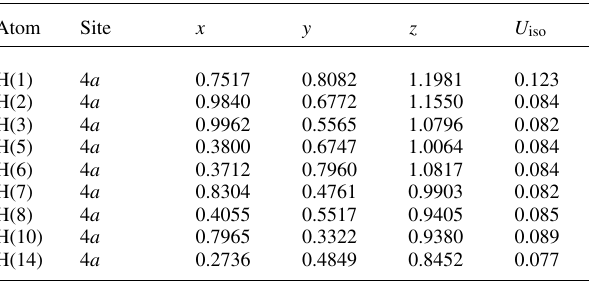
Table 2. Atomic coordinates and displacement parameters (in Å 2 )